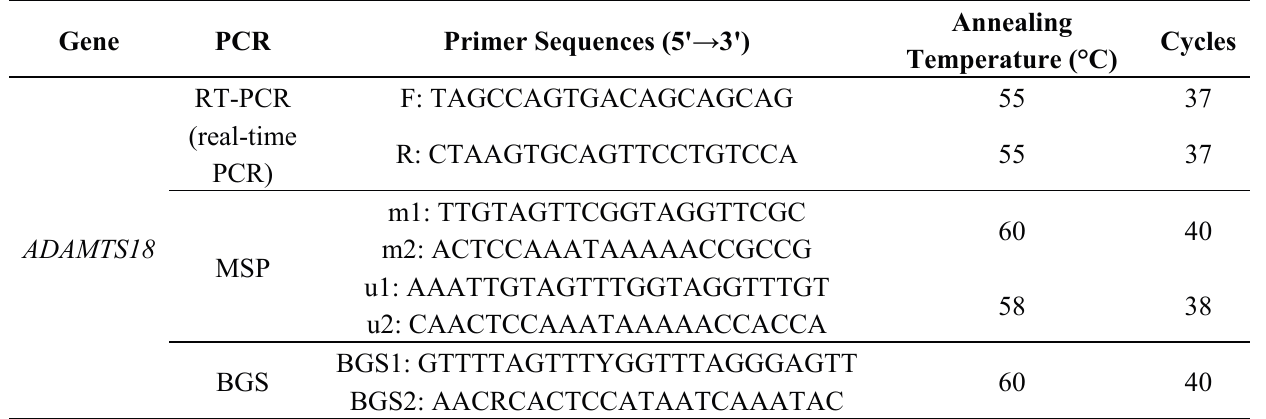
internal control. Table 2 lists the primer sequences and the cycling parameters for RT-PCR analysis. Table 2. The sequences and conditions of PCR